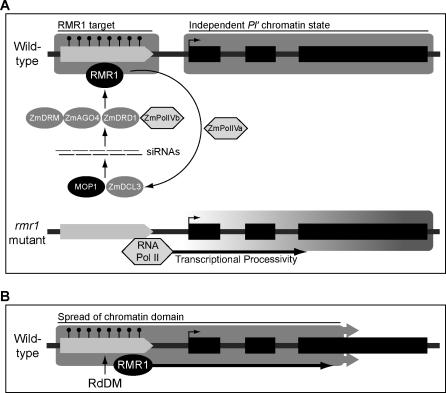
Two General Models for RMR1 Action at the Pl1-Rhoades AlleleRMR1 maintains nonsymmetrical methylation of the doppia element (light gray arrow) upstream of the pl1 coding region (exons in black) via an RdDM pathway. Small RNAs are produced in a RMR1-dependent fashion with homology to the doppia element, and maize orthologs of characterized RdDM proteins, as well as RMR1, then act as effectors of these siRNAs, facilitating cytosine methylation at complementary sequences of the DNA template. In the model shown in (A), the heterochromatic region of doppia is maintained and established independently of the Pl1-Rhoades chromatin state, but derepression of the upstream repetitive element in an rmr1 mutant causes changes in the nearby genic region through processivity of RNA polymerase II or other general transcription factors that bind the upstream elements. In the model shown in (B), the doppia element is repressed by the same RdDM pathway shown in (A), but the Pl′ state represents a spread of the heterochromatic domain beyond the region targeted by the siRNAs for cytosine methylation. This spread might be mediated by RMR1 activity, or by another chromatin modifier. In (B), loss of RMR1 would lead to a loss of the repressive chromatin state at doppia and the ability for it to spread.